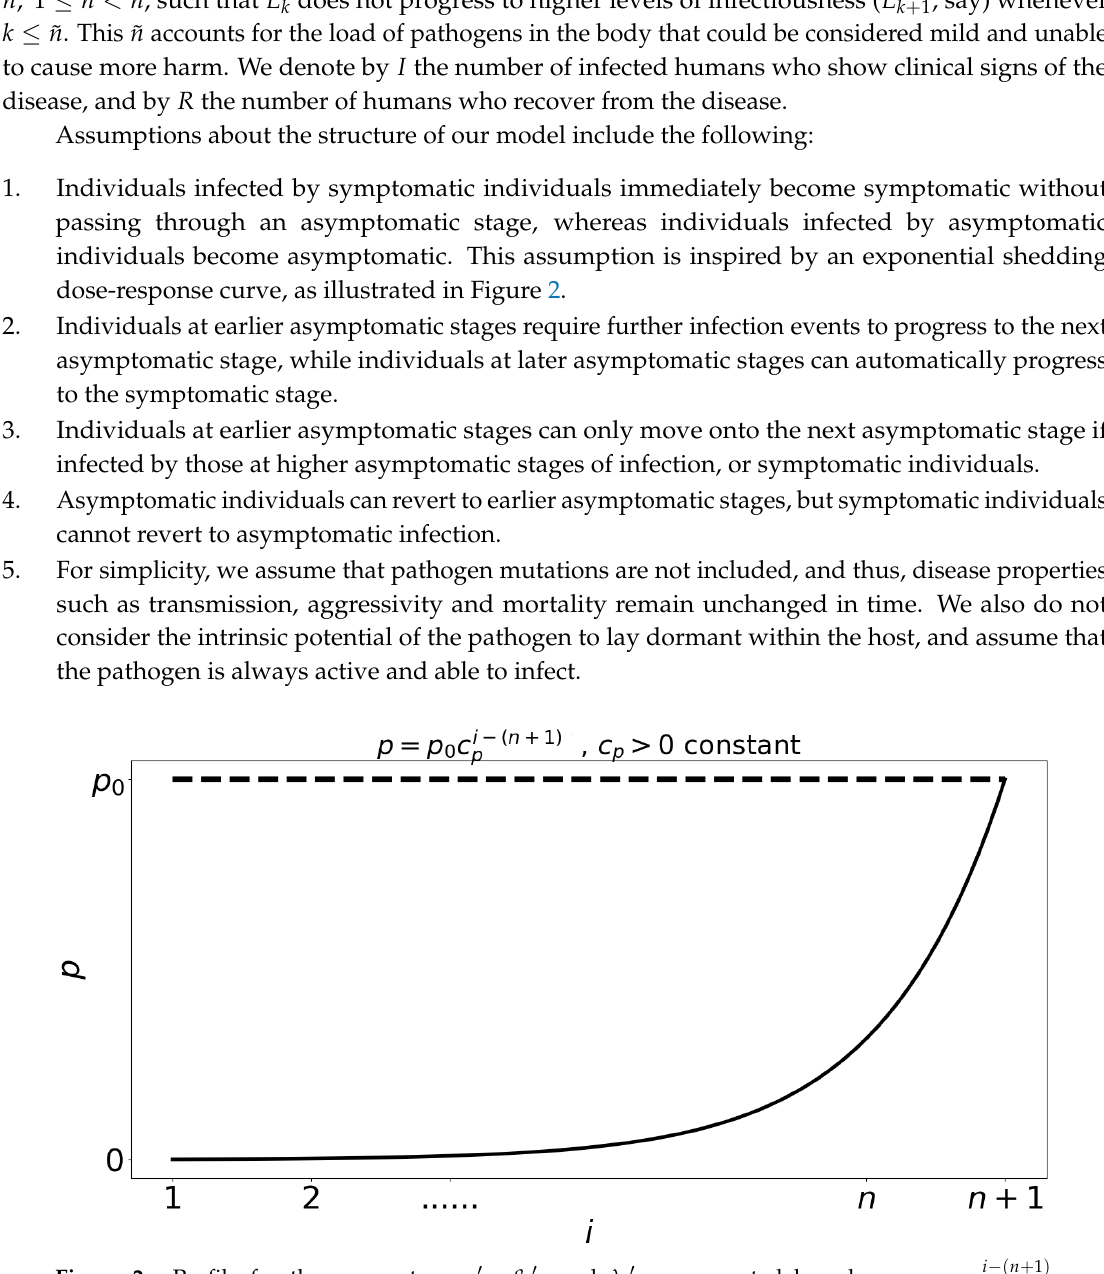
Figure 2. Profile for the parameters α i (cid:48) s, β i (cid:48) s and λ i (cid:48) s, represented here by p = p 0 c i i ∈ { 1,2, . . . , n } , where c p > 0 is a constant. More details in Technical